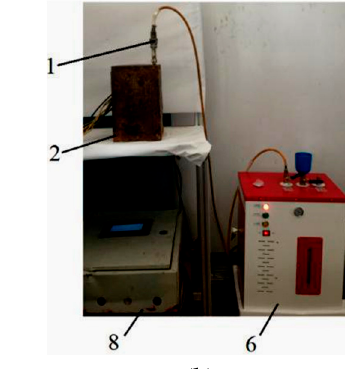
soil temperature, water content control box; 9. Soil water content sensor; 10. Soil temperature sensor.